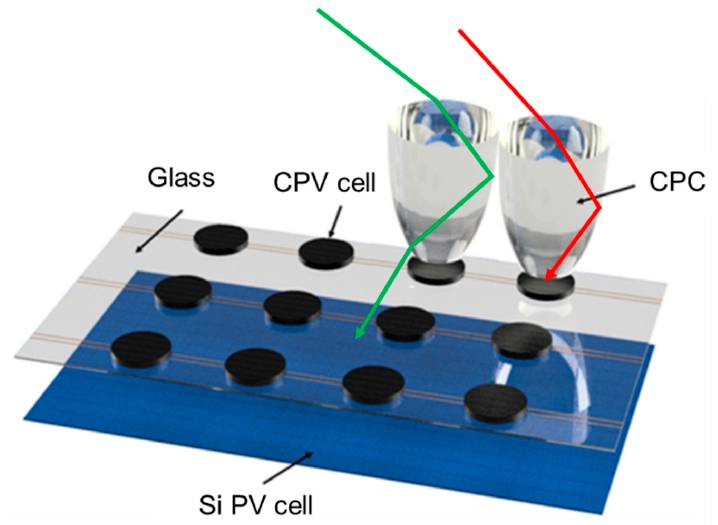
Figure 2. Concept of the static concentrator photovoltaics module. The light (green) with an incidence angle greater than the acceptance angle of the CPC leaks out of the CPC and enters the Si cell. The light (red) with an incidence angle less than the acceptance angle of the CPC is captured by the CPC and enters the CPV cells.